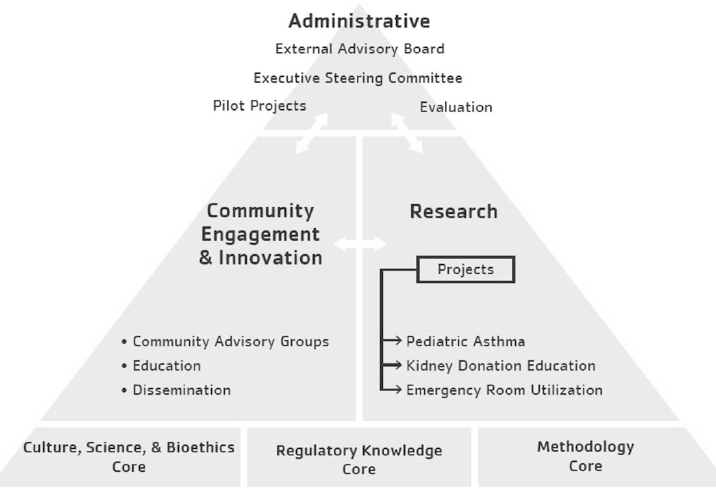
Figure 1. Collaborative Research Center for American Indian Health Organizational Structure.